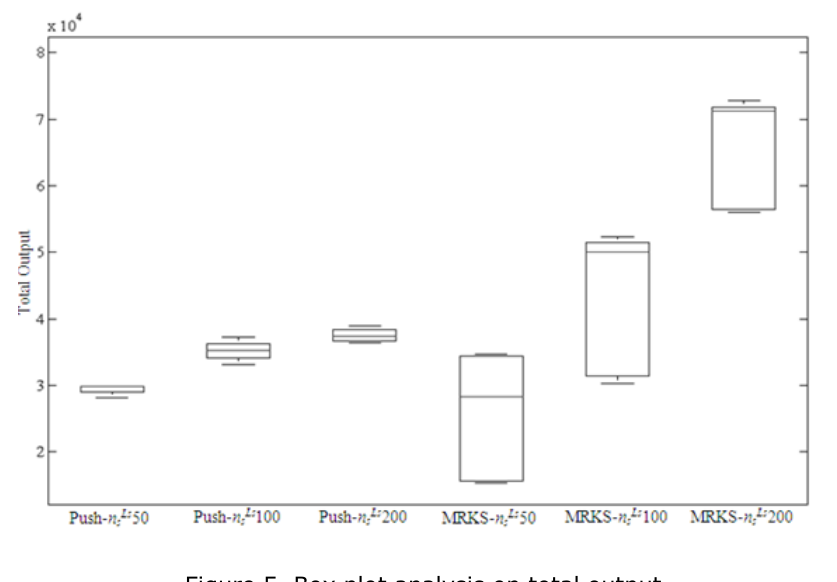
Figure 5 . Box plot analysis on total output